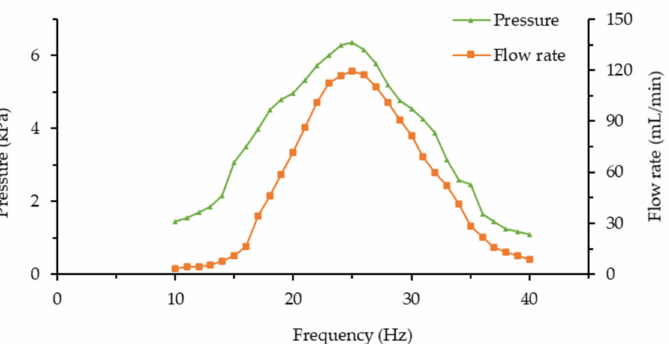
Figure 10. The output pressure and flow rate curves of the piezoelectric pump, when the voltage was 100 V.